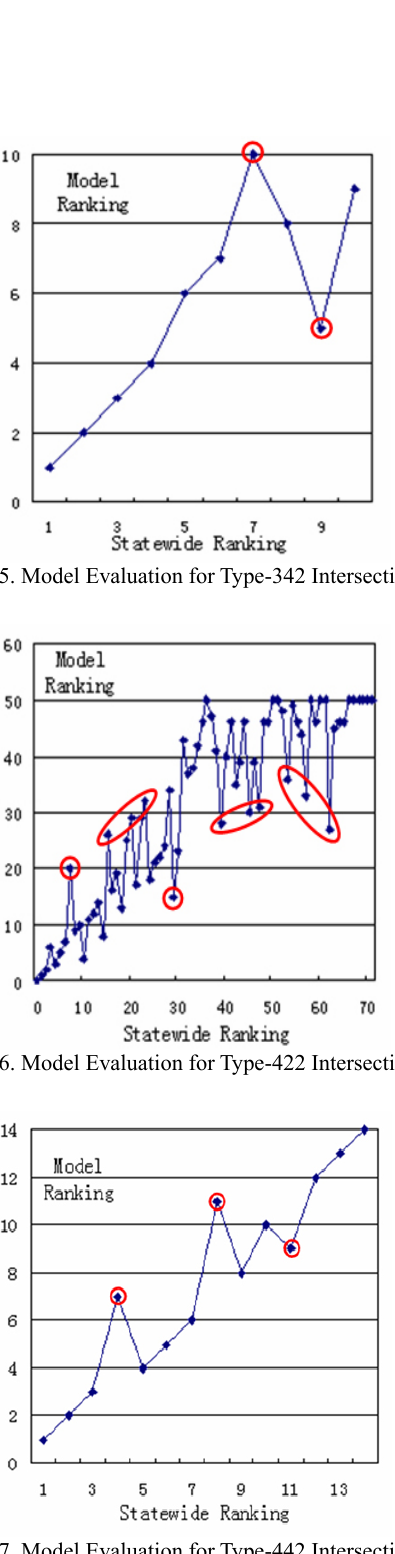
Fig.7. Model Evaluation for Type-442 Intersection